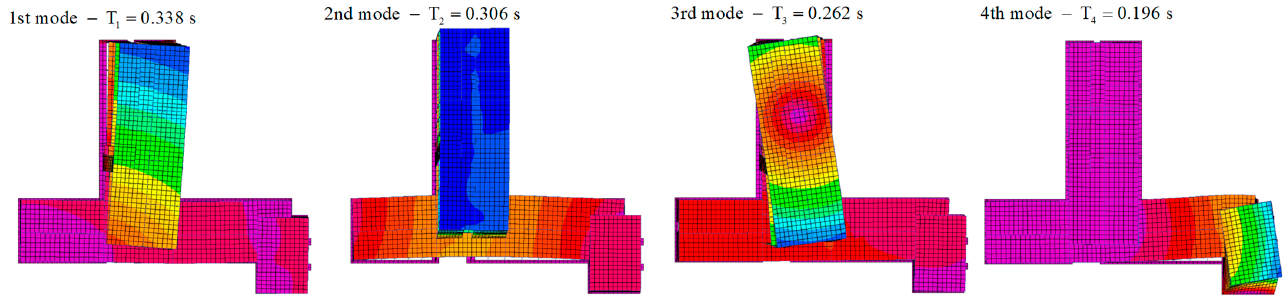
Figure 12. Weak positions in the structure due to vertical loads.